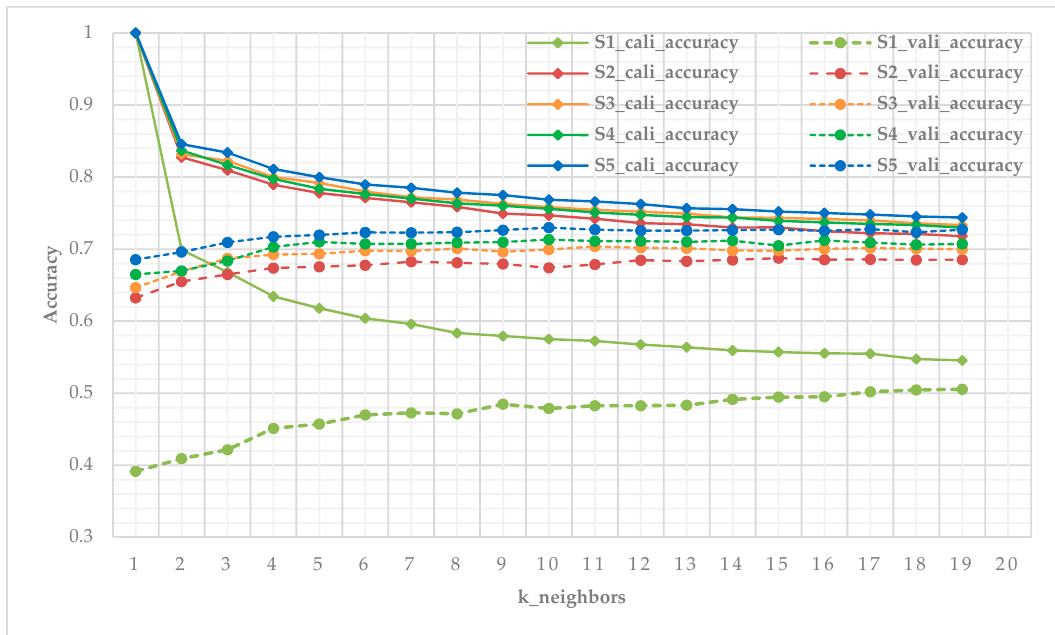
Figure 10. Iterative testing of optimal k value of KNN classifier using calibration data and validation